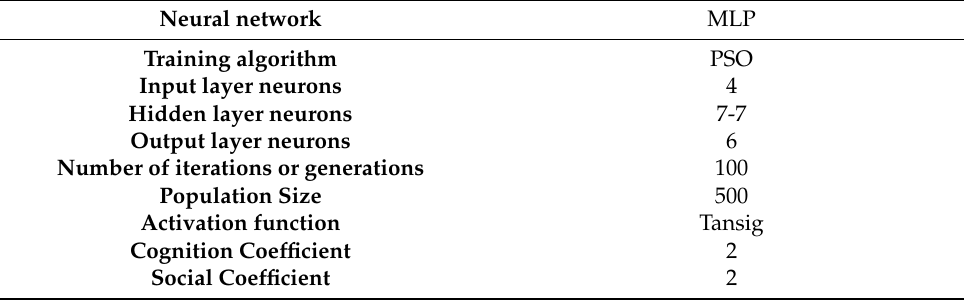
Table 3. Specifications of the PSO algorithm for initial modeling of the